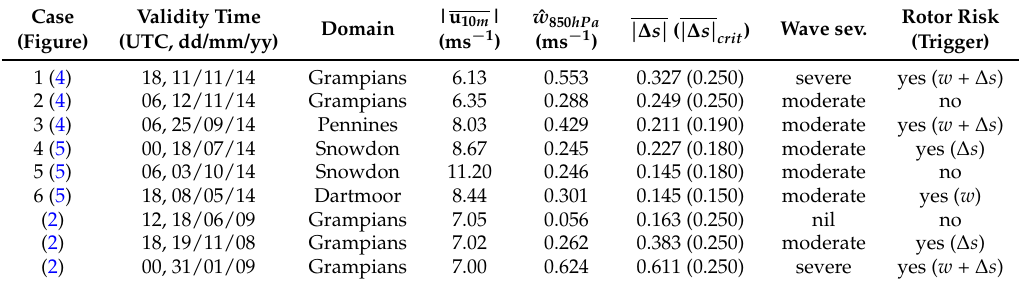
Figure 5. As Figure 2, but for the Snowdon (north Wales) domain at ( Left ) 00Z 18 July 2014 ( w at 1000 m shown), ( Center ) 06Z 3 October 2014 and ( Right ) the Dartmoor domain (southwest England) at 18Z 8 May 2014. Table 1. Characteristics of case examples plotted in Figures 2, 4 and 5 (see the text for the explanation). The diagnosed wave severity is given in the penultimate column. Indication of whether rotor risk warnings are triggered by ˆ w 850 hPa exceeding 0.3 (‘ w ’), | ∆ s | exceeding | ∆ s | crit (‘ ∆ s ’) or both is indicated in parentheses in the final